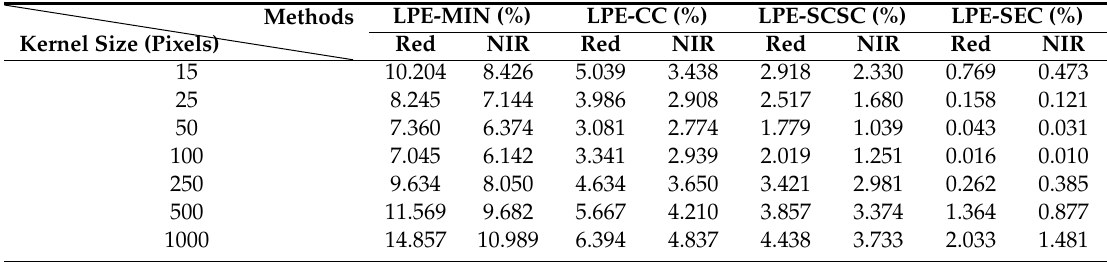
Table 2. The relative di ff erence of median radiance (RDMR) of the improved LPE-TC models with the kernel sizes ranging from 15 pixels to 1000